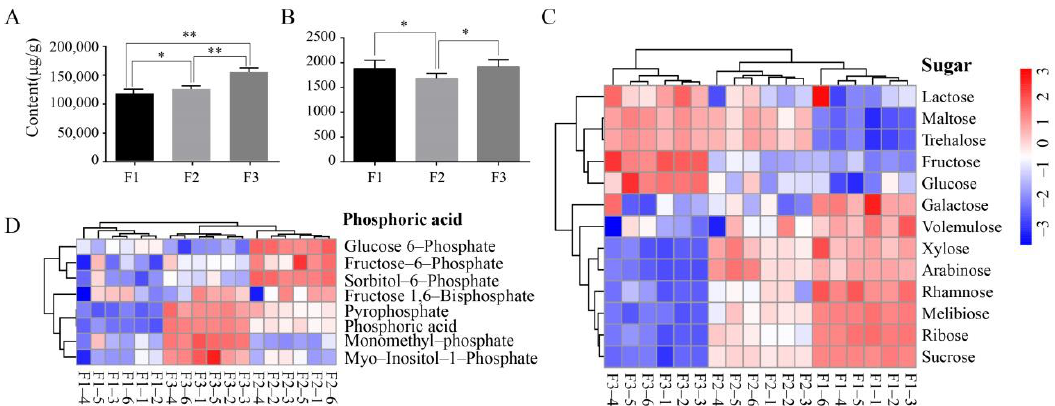
Figure 2. Metabolomics contents in olive fruits with different colors (F1–F3; green, turning stage (semi-green/half-purple), and purple fruits designated as F1, F2, and F3, respectively). ( A ) Total fatty acid contents among olive fruits at different maturity stages. ( B ) Total polyphenol contents among different mature olive fruits. Asterisks are significantly different (* p ≤ 0.05; ** p ≤ 0.01). ( C , D ) Heat map visualization of sugar and phosphorylated compounds.